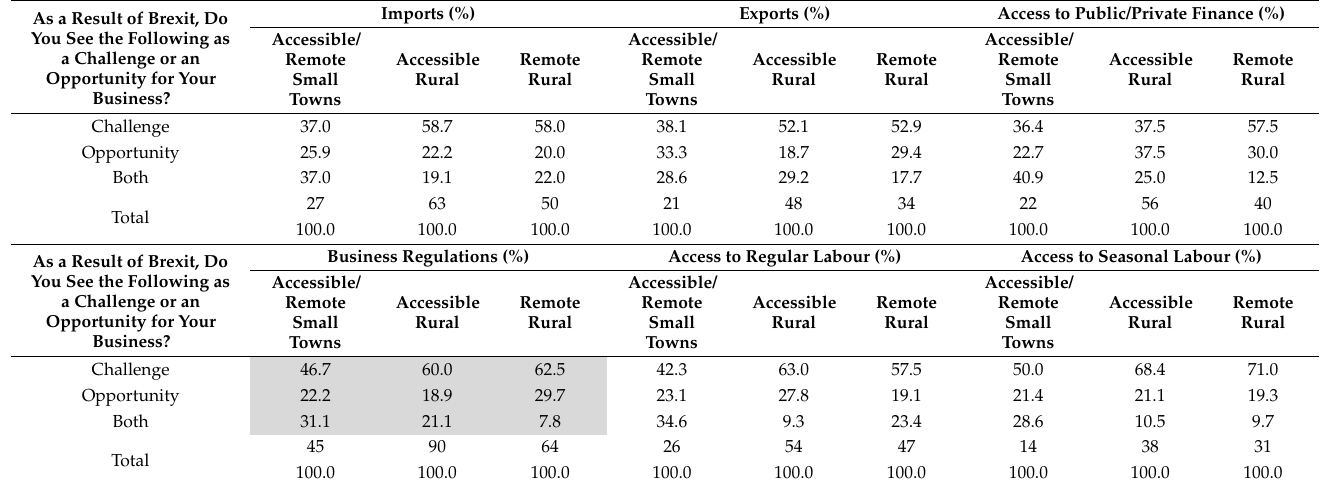
Table 8. Comparative analysis of challenges related to Brexit between non-land-based rural businesses that have a relationship with the forestry sector in different rural classifications in Scotland.